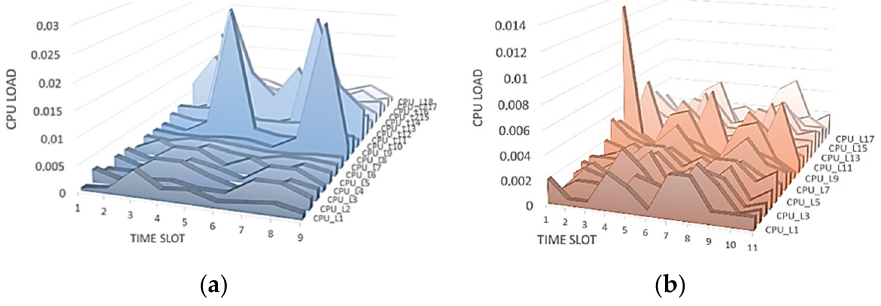
Figure 4. Changing the CPU load when analyzing raw data: ( a ) for node i ; and ( b ) for node j .